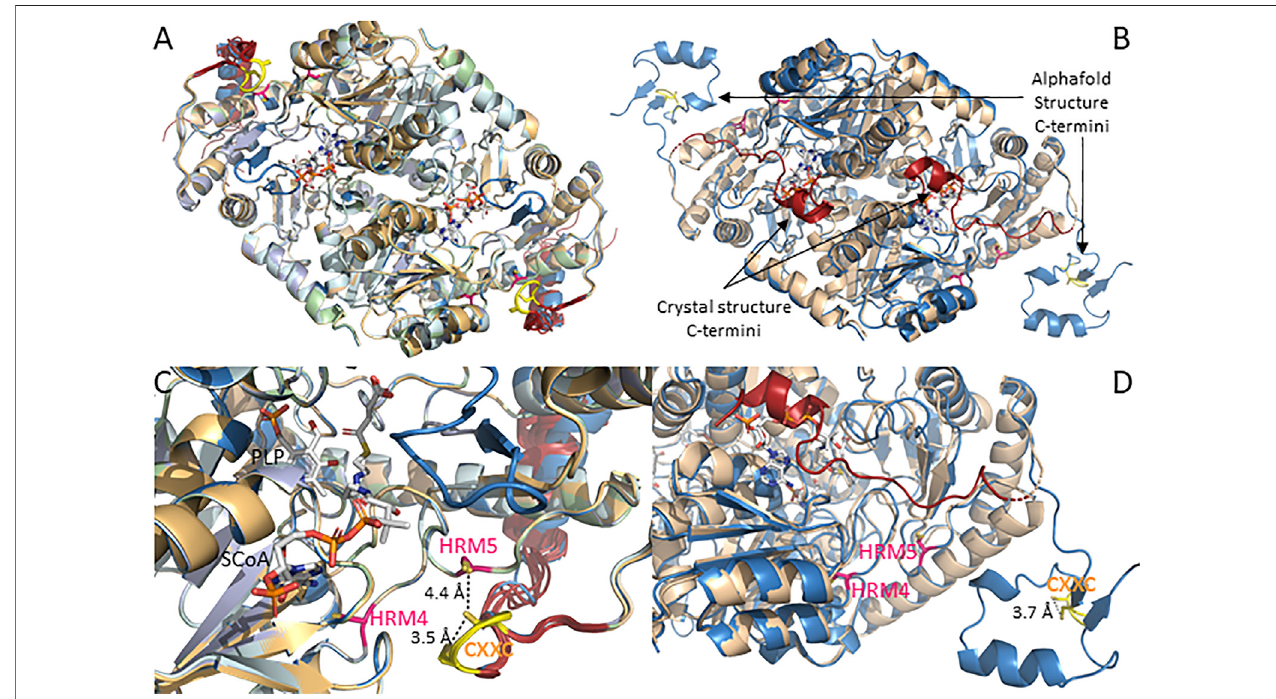
FIGURE 2 | AlphaFold structures for mammalian ALAS1 and ALAS2 reveal C-terminal divergences from the human ALAS2 crystal structure. (A) . Alignment of AlphaFold-predicted structures of ALAS1 from human (UniProt accession # P13196), orangutan (UniProt accession Q5R9R9), bovine (UniProt accession A6QLI6), beluga whale (UniProt accession Q9XS79), mouse (UniProt accession Q8VC19), and rat (UniProt accession # P13195). (B) . Alignment of human ALAS2 crystal and AlphaFold-predicted structures . AlphaFold-predicted structure (UniProt accession # P22557; blue) and crystal structure (PDB code 6HRH; beige with red C-termini). (C) . Zoom of panel (A) . (D) . Zoom of panel (B)